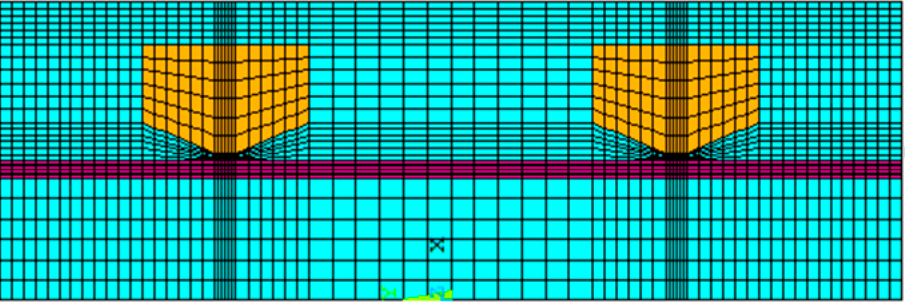
Figure 9. Finite element model for the magnetic analysis of the linear brake.